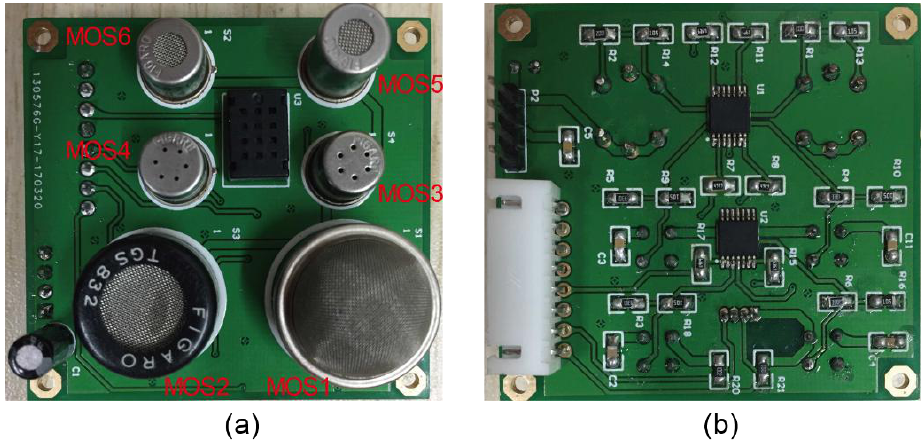
Figure 1. Printed circuit board (PCB) for data acquisition based on metal oxide semiconductor (MOS) sensor array. ( a ) front view; ( b ) back view.